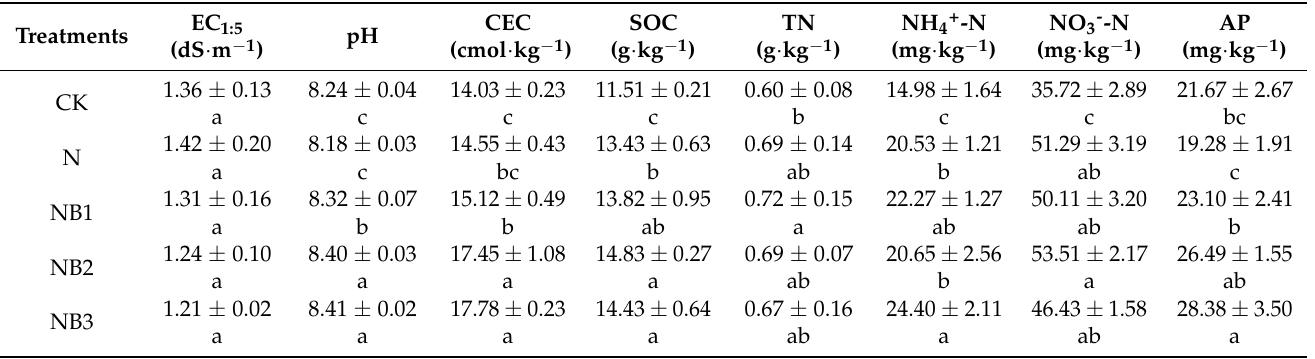
Table 1. Basic soil properties for all the treatments (mean ± standard deviation), and the one-way ANOVA results with the least significant difference